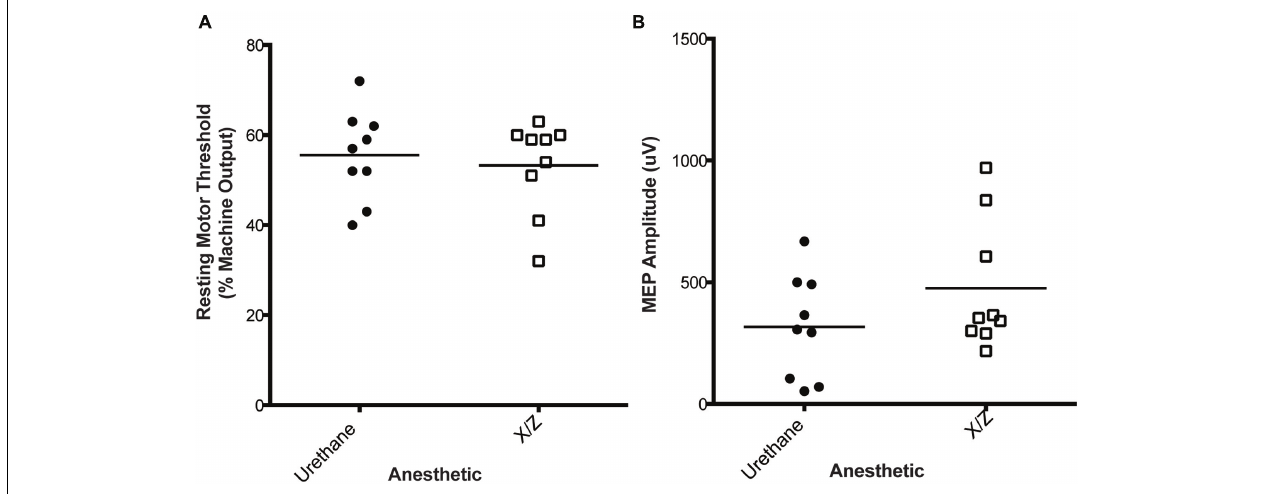
FIGURE 2 | No differences were observed in resting motor threshold (RMT) (A) or baseline amplitude (B) in the MEPs recorded from the brachioradialis muscle in rats anesthetized with urethane ( n = 9) or xylazine/zoletil ( n = 9). Baseline amplitude was averaged from MEPs recorded in final 5 min of pre-iTBS baseline. X/Z = xylazine/zoletil.